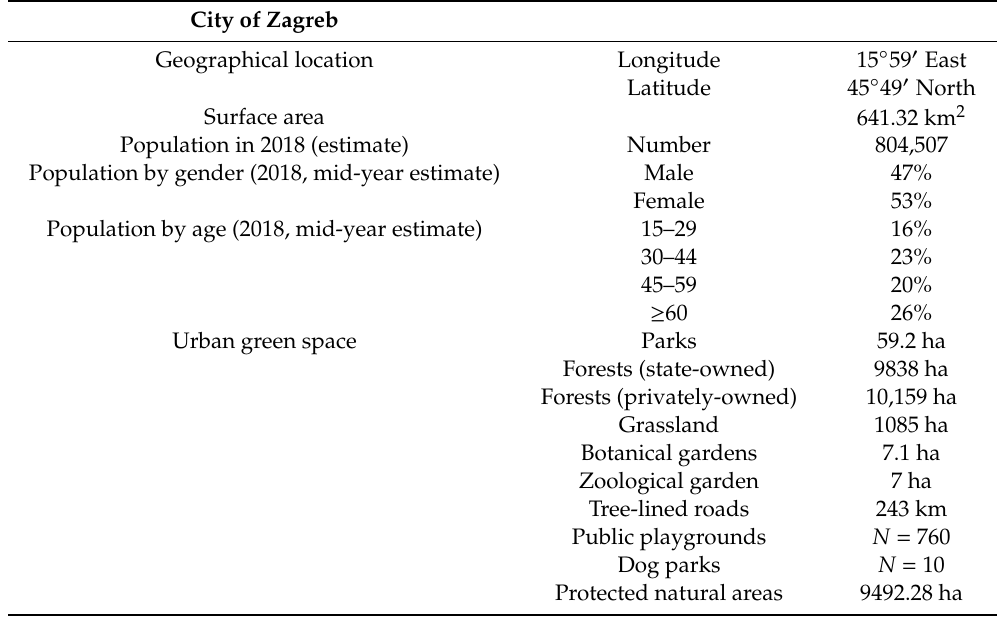
Table 1. General information on the city of Zagreb and its urban green space. Source: Statistical Yearbook of the City of Zagreb for 2019